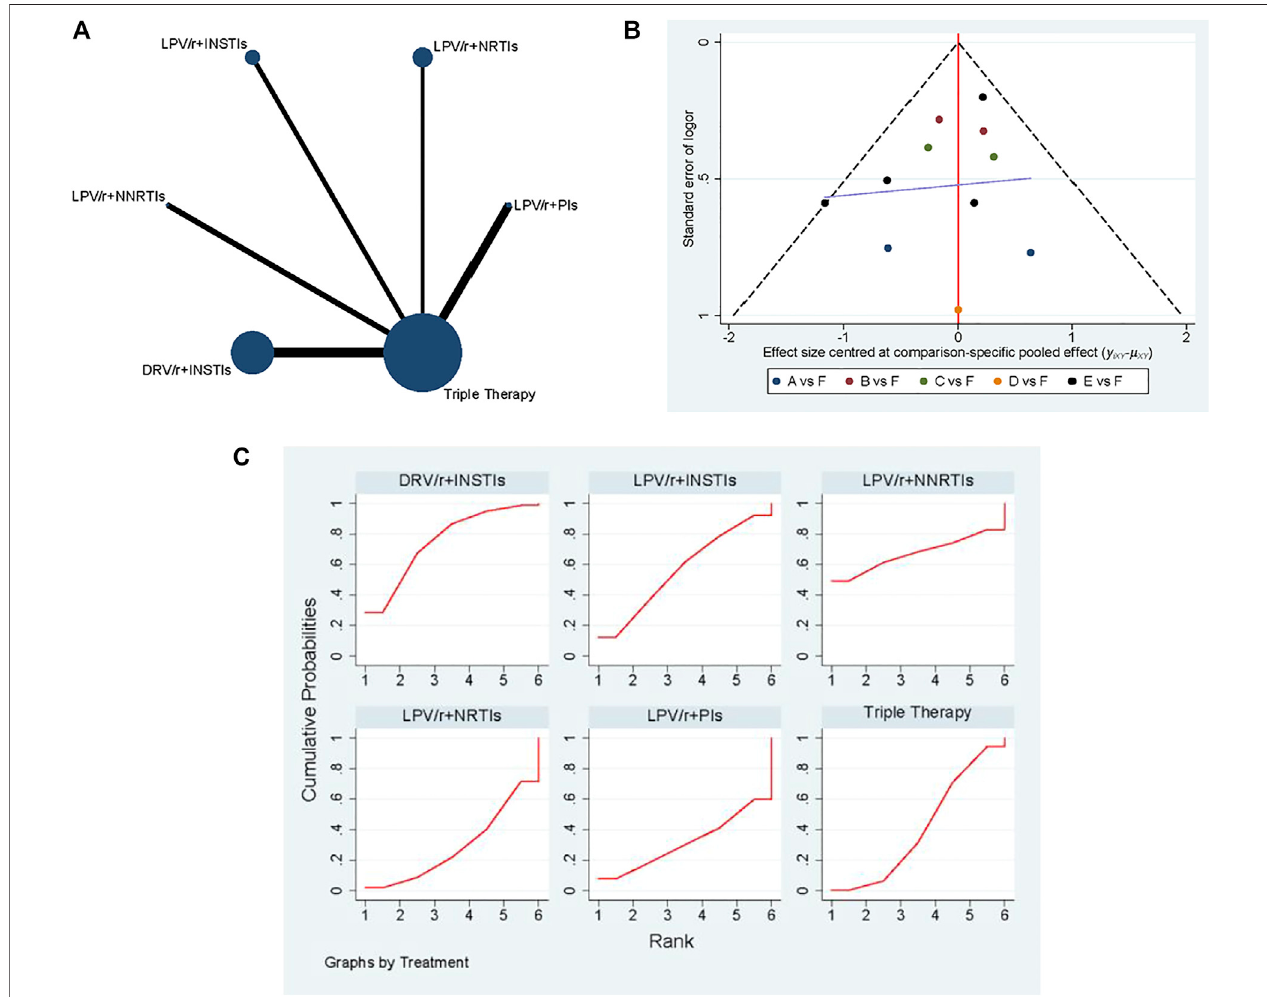
FIGURE 3 | The results of network meta-analysis with viral suppression rate. (A) The network diagram. (B) The comparison-correction funnel diagram (A: LPV/r + PIs, B: LPV/r + NRTIs, C: LPV/r + INSTIs, D: LPV/r + NNRTIs, E: DRV/r + INSTIs, F: TT). (C) : SUCRA value ranking chart.